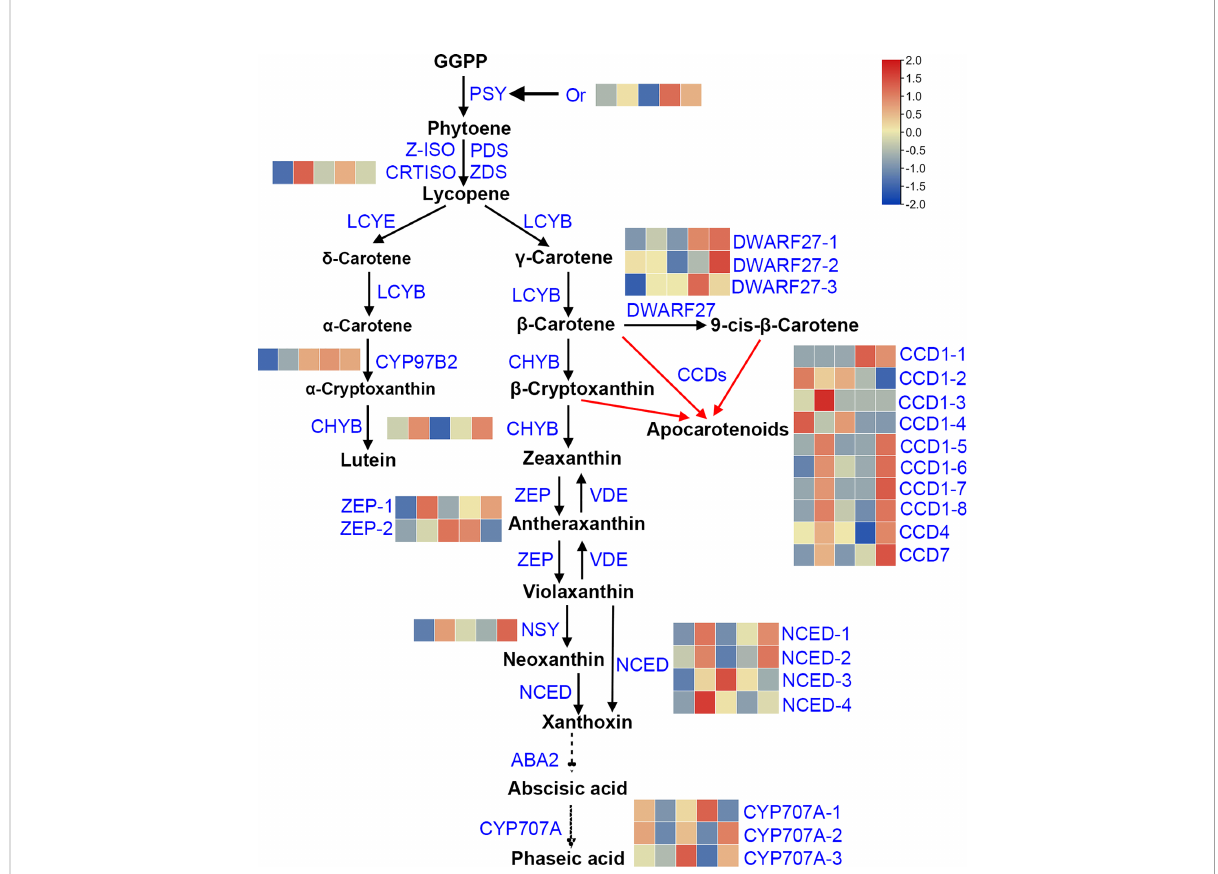
FIGURE 3 Pathway analysis of carotenoid metabolic in sweetpotato fl esh. This pathway was constructed based on the KEGG pathway and references. GGPP, geranylgeranyl diphosphate; PSY, 15-cis-phytoene synthase; PDS, 15-cis-phytoene desaturase; Z-ISO, 15-cis- z -carotene isomerase; ZDS, z -carotene desaturase; CRTISO, prolycopene isomerase; LCYB, lycopene b -cyclase; LCYE, lycopene ϵ -cyclase; DWARF27, b -carotene isomerase D27; CCD1, carotenoid cleavage dioxygenase 1; CCD4, carotenoid cleavage dioxygenase 4; CCD7, carotenoid cleavage dioxygenase 7; CHYB, b -carotene hydroxylase; CYP97B2, cytochrome P450 97B2-type epsilon-hydroxylase; ZEP, zeaxanthin epoxidase; VDE, violaxanthin de- epoxidase; NSY, neoxanthin synthase; NCED, 9-cis-epoxycarotenoid dioxygenase; ABA2, xanthoxin dehydrogenase; CYP707A, (+)-abscisic acid 8 ’ -hydroxylase. Heatmap of the expression of DEGs involved in carotenoid synthesis pathway, rows and columns represent gene names and samples (from left to right is W, LY, Y, O and OR),